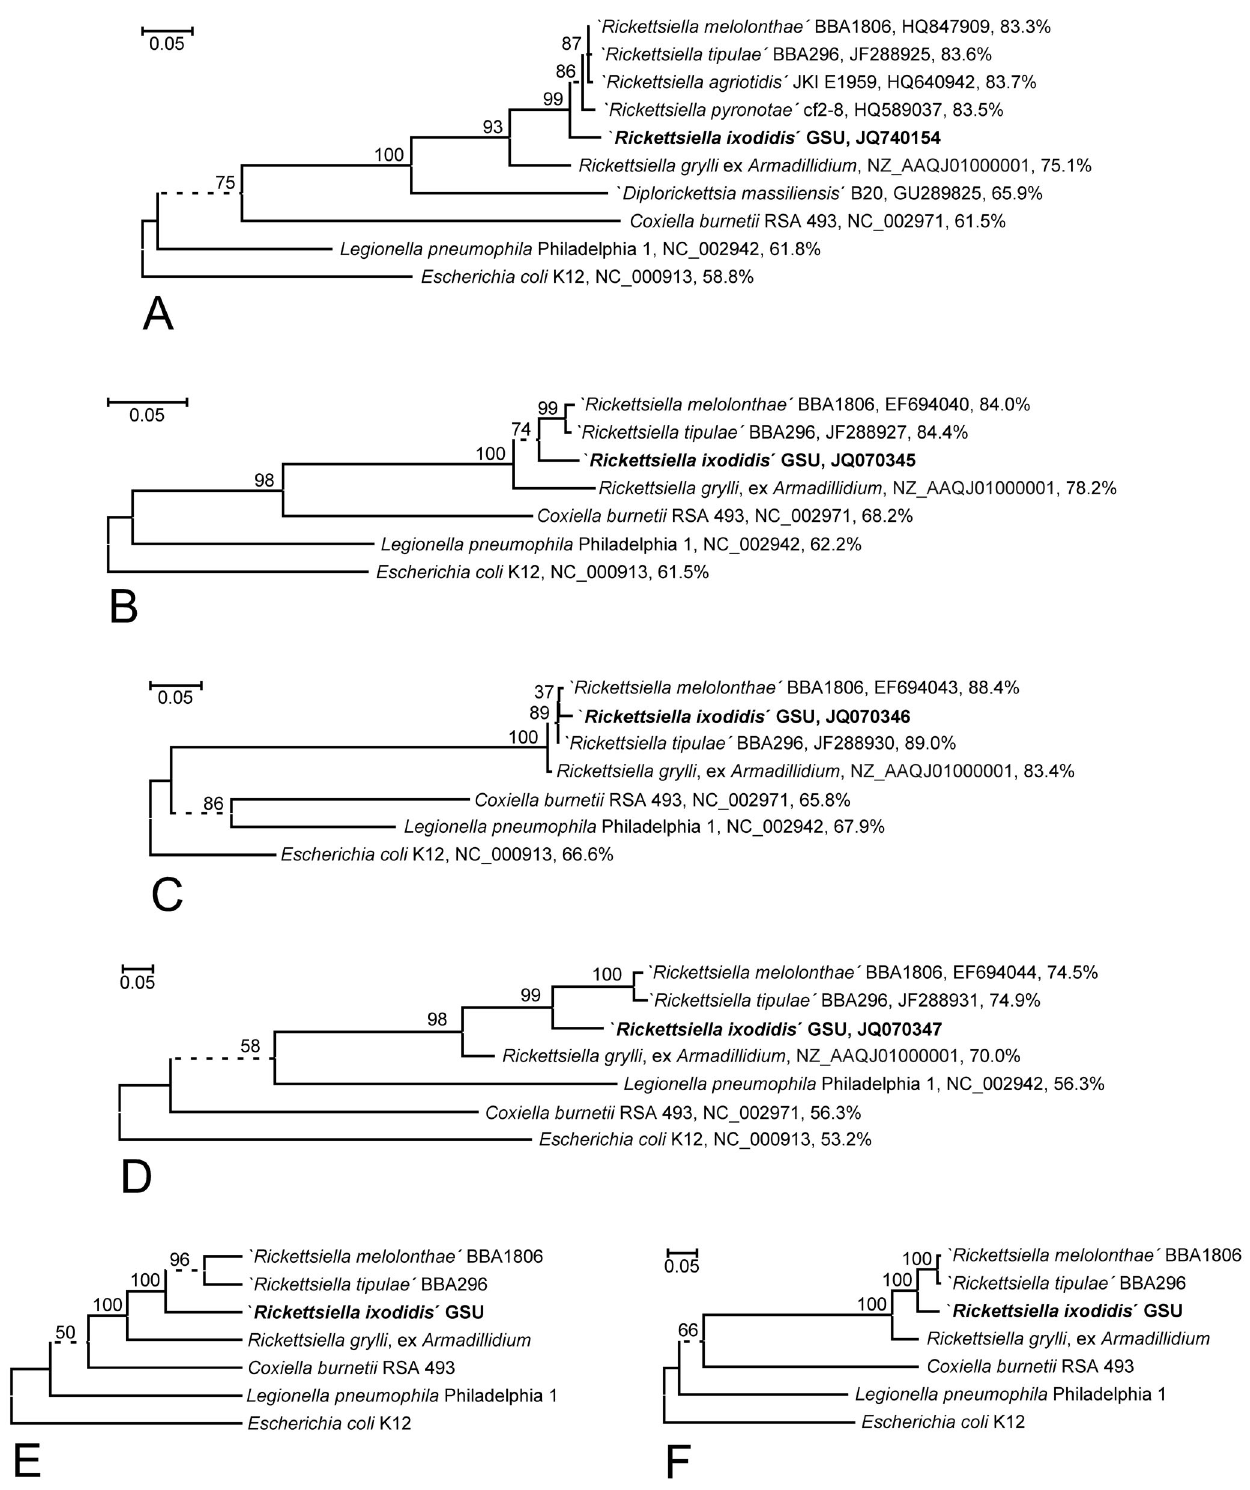
Figure 3. Bacterial phylogenies generated from MLST marker sequence alignments. A–D, F: Bacterial ML phylogenies generated from hypervariability filtered ftsY ( A ), gidA ( B ), rpsA ( C ), and sucB ( D ) gene sequences or a concatenation of these ( F ). Terminal branches are labelled by genus and species, pathotype and/or strain designations, GenBank accession numbers, and pairwise nucleotide sequence identity percentages respect to the ‘ Rickettsiella ixodidis ’ GSU sequence as calculated from a p-distance matrix with. Numbers on internal branches indicate bootstrap support values; branches that do not receive . 90% bootstrap support are represented by dashed lines. Trees were rooted using Escherichia coli as outgroup. The size bar corresponds to 5% sequence divergence. E: Extended majority rule consensus tree topology generated from 24 phylogenies reconstructed by the ML, ME, or NJ method from hypervariability filtered nucleotide or deduced amino acid sequence alignments of the ftsY , gidA , rpsA , or sucB marker. For compatibility with the other markers, specimens ‘ R. agriotidis ’, ‘ R. pyronotae ’ and ‘ Diplorickettsia massiliensis ’ were removed